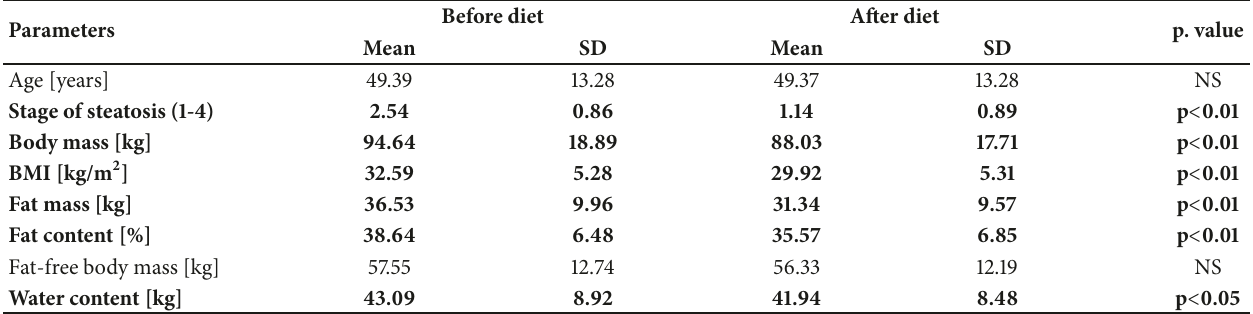
Table 2: The differencesin body contentand the anthropometricparametersbefore and after the dietary intervention.BMI: body mass index.